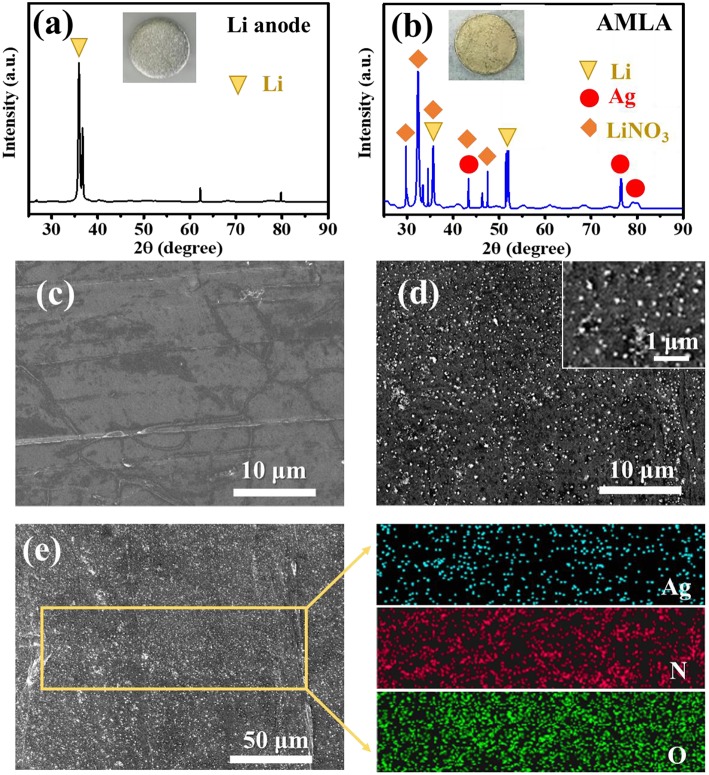
The XRD curves of Li anode (a) and AMLA (b), and the circle sheets in the figures represent the Li anode in different states. (c) The SEM image of Li anode. (d) The SEM image of AMLA. (e) The EDS images of ALMA, and the blue spots represent the element Ag, the red ones represent the element N, and the green ones represent the element O.